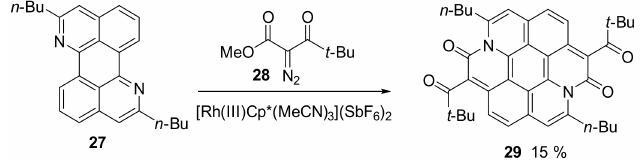
Scheme 6. Synthesis of compound 29.